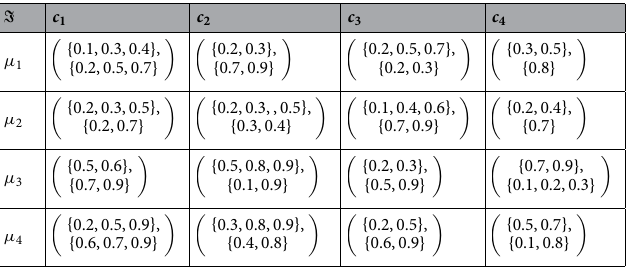
Table 1. The q -ROHF relation in ℑ